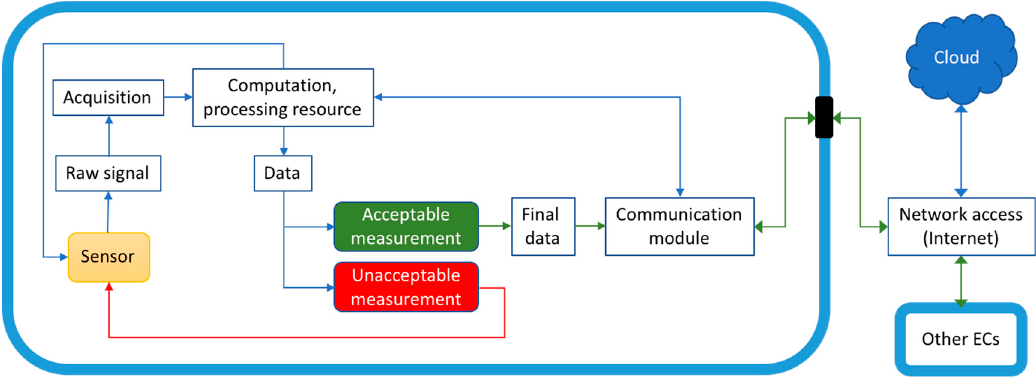
Figure 5. A simplified edge computing approach. A sensor generates raw data, which is locally processed and evaluated. If the outcome meets certain criteria, the data is then communicated to the cloud for further processing/computing and storage.